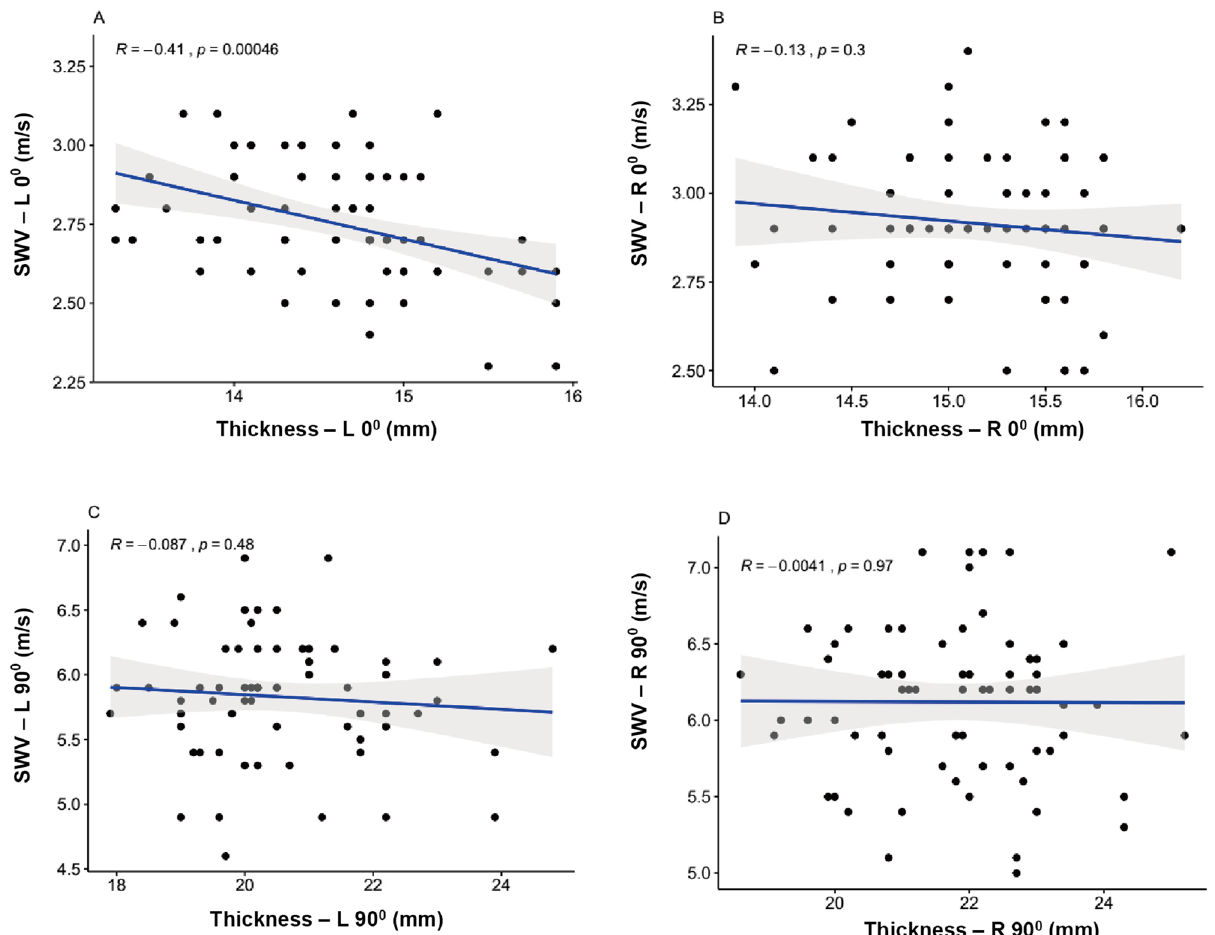
Figure 5. Scatterplots of MD thickness and SWV in healthy participants at L0° ( A ), R0° ( B ), L90° ( C ), and R90° ( D ). MD middle deltoid; SWV mean shear wave